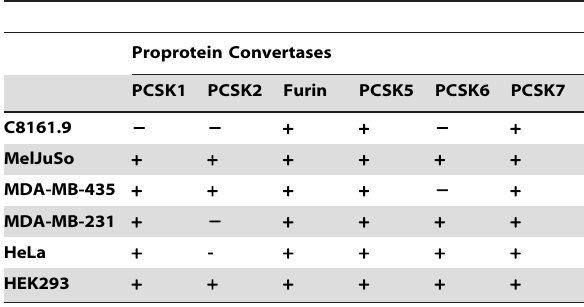
Table 1. RT-PCR analysis of the six members of PC family involved in the secretory